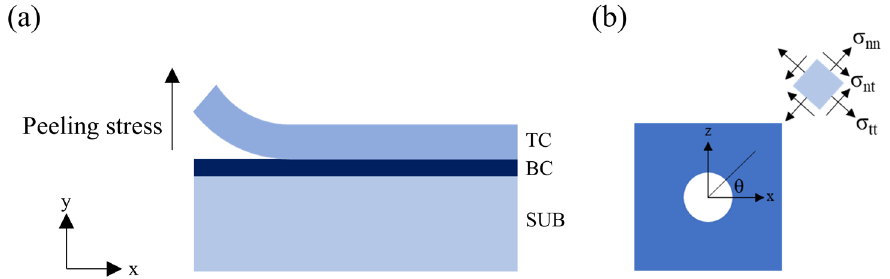
Figure 10. Outlined photograph for ( a ) peeling stress and ( b ) interfacial stresses.